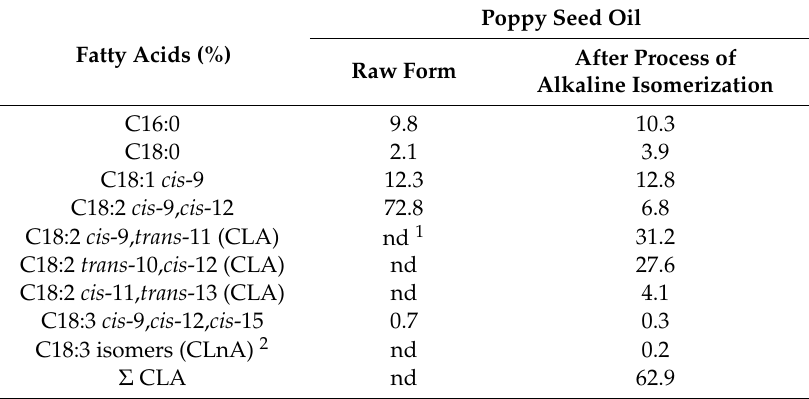
Table 1. Content of main fatty acids in poppy seed